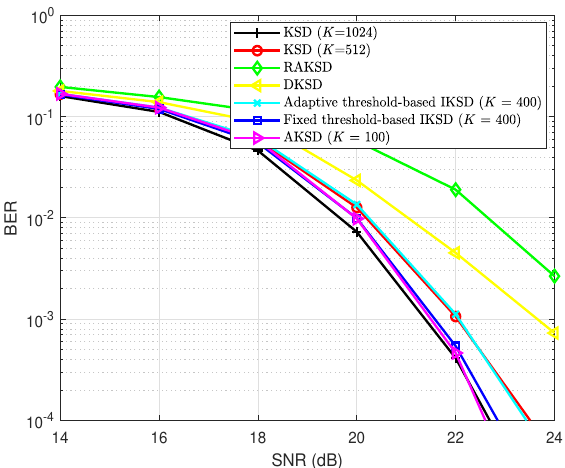
Figure 2. The BER performance comparison of KSD algorithms for a 64 × 64 MIMO system with 16-QAM.